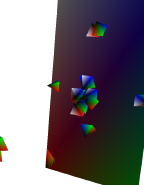
Figure A1. Visualization of camera poses for the dataset 0. The rectangle indicates the coding screen and each pyramid denotes a calibration camera pose. The projection center corresponds to the tip of each